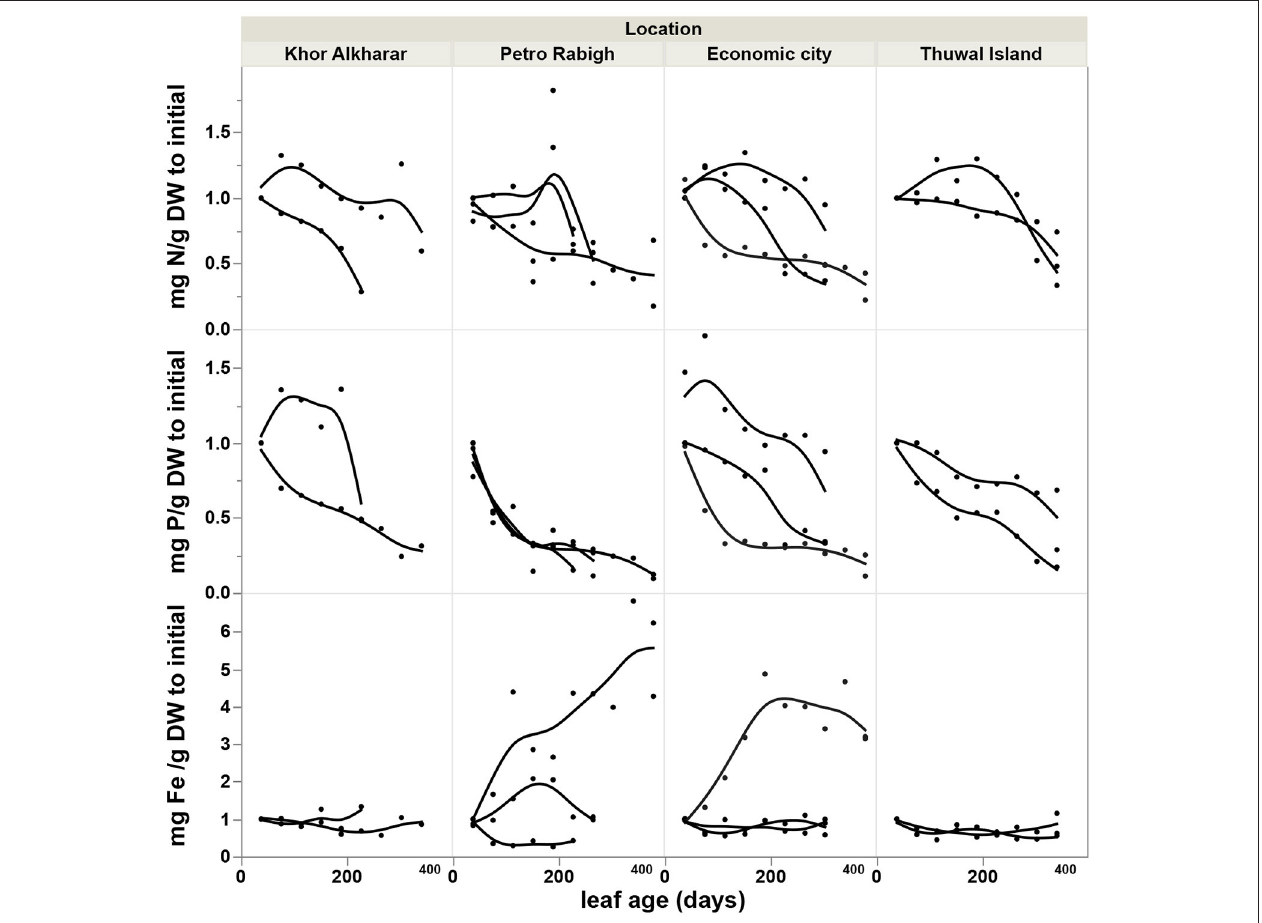
FIGURE 4 | Accumulation rate of nutrients concentration (Difference in mg g DW − 1 to the value of the first leaf) with the age of Avicennia marina leaves in the Central Red Sea, each smoothed line present one tree branch in a tree.